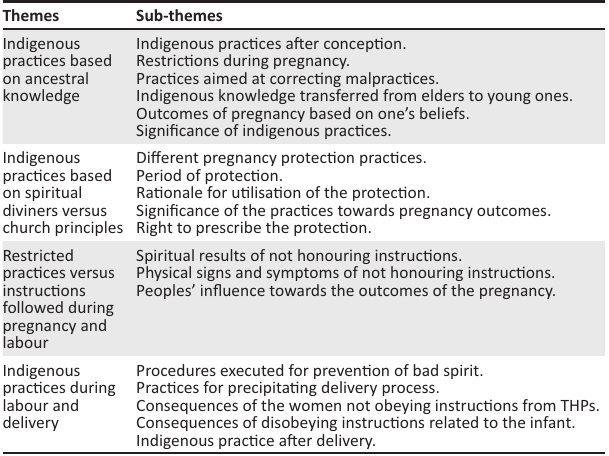
TABLE 1: Themes and sub-themes reflecting the indigenous practices of preg- nant women at the Dilokong hospital in Limpopo province, South